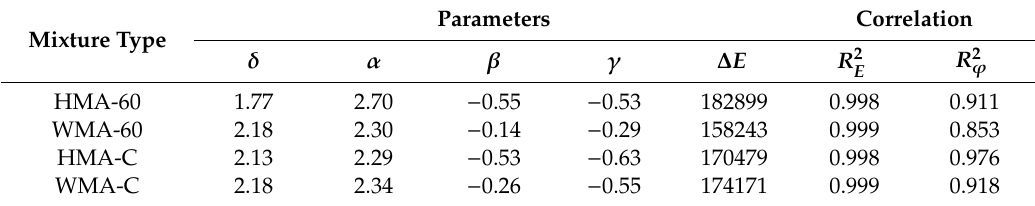
Table 3. Fitting parameters of the SM (Arrhenius equation).